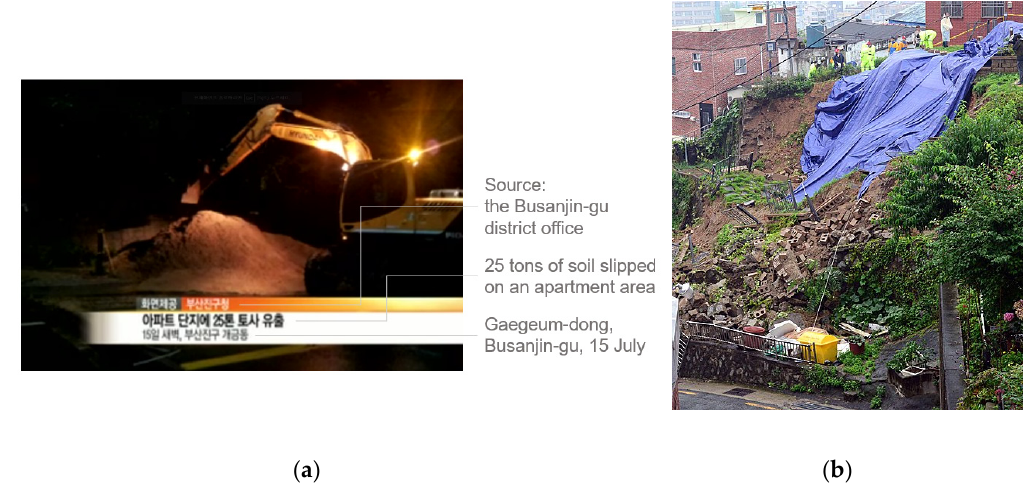
Figure 10. Historical slope failures that occurred within the “Null” level including ( a ) soil loss of a cut slope in 2012 (captured from a Korean news video clip) and ( b ) failure of an embankment within a housing area in